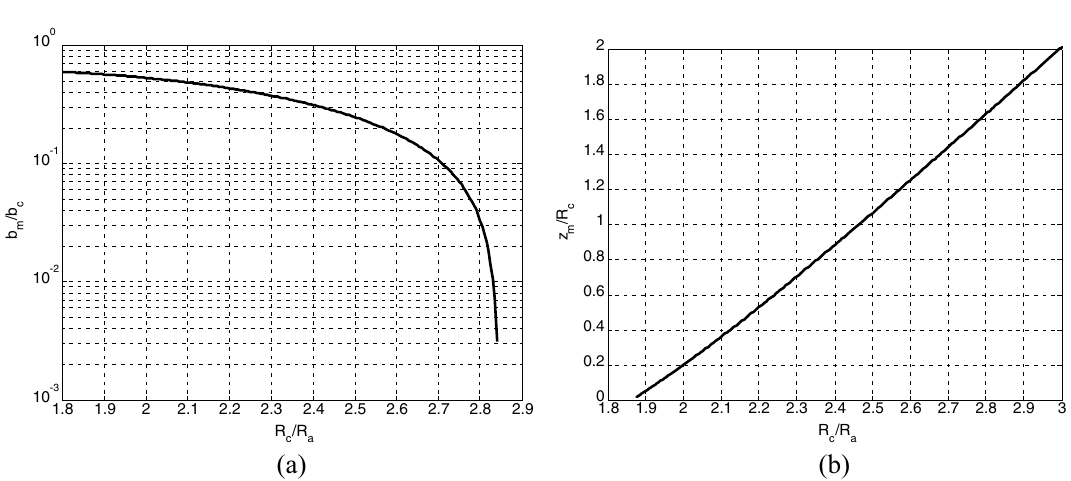
Figure 6. Design curves of sheet beam gun for ( a ) compression factor and ( b ) throw